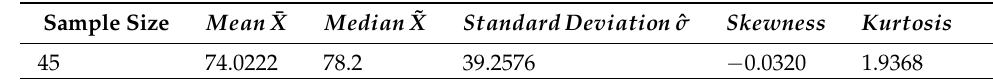
Table 20. Summary statistics of data-IV.